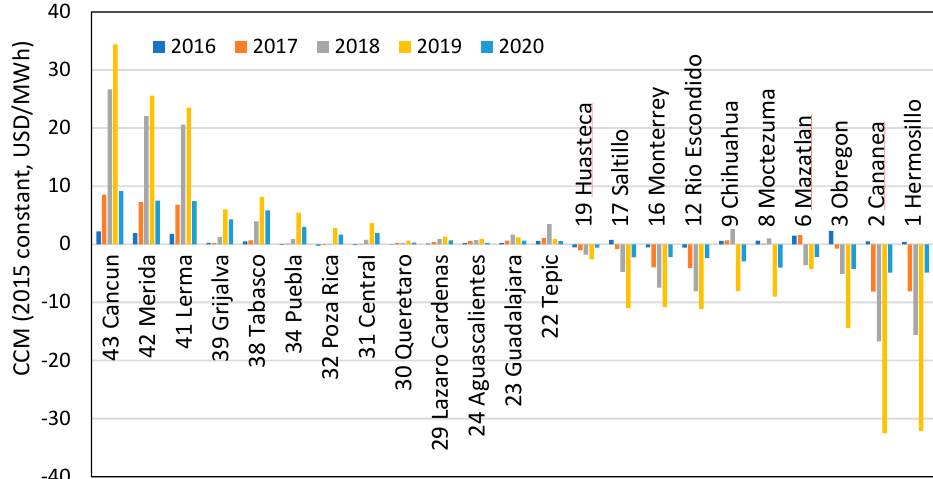
Figure 6. Average yearly CCM for representative transmission regions of the SIN in the period 2016–2020.